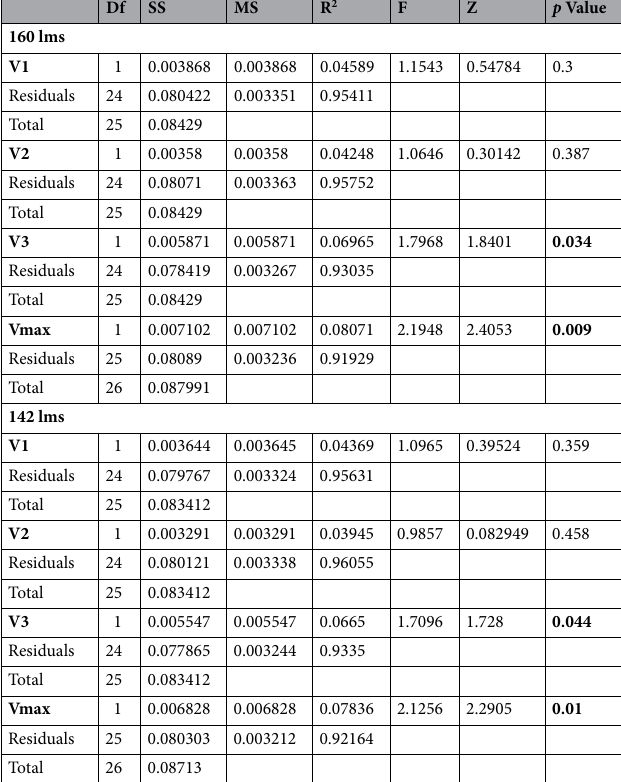
Table 4. Multivariate regressions of full torso shape (160lms) and non-muscular torso shape (142 lms) on running performance at different workloads (V1, V2, V3 and Vmax). (Note that sample size is N = 27 for Vmax, but N = 26 for V1, V2 and V3). Significant values are in bold.